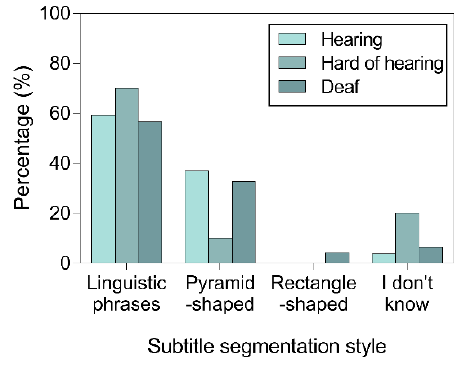
Figure 6. Segmentation preferences by group.